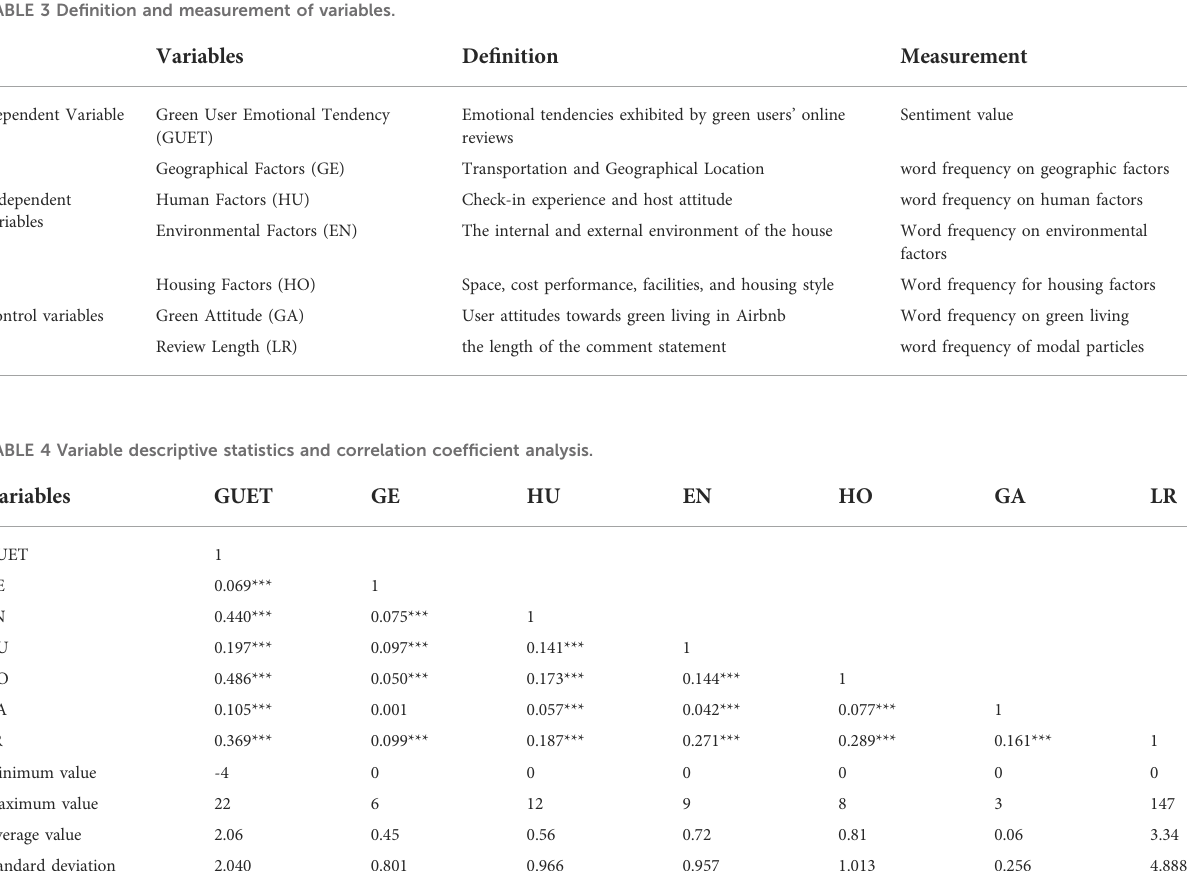
TABLE 3 De fi nition and measurement of variables.